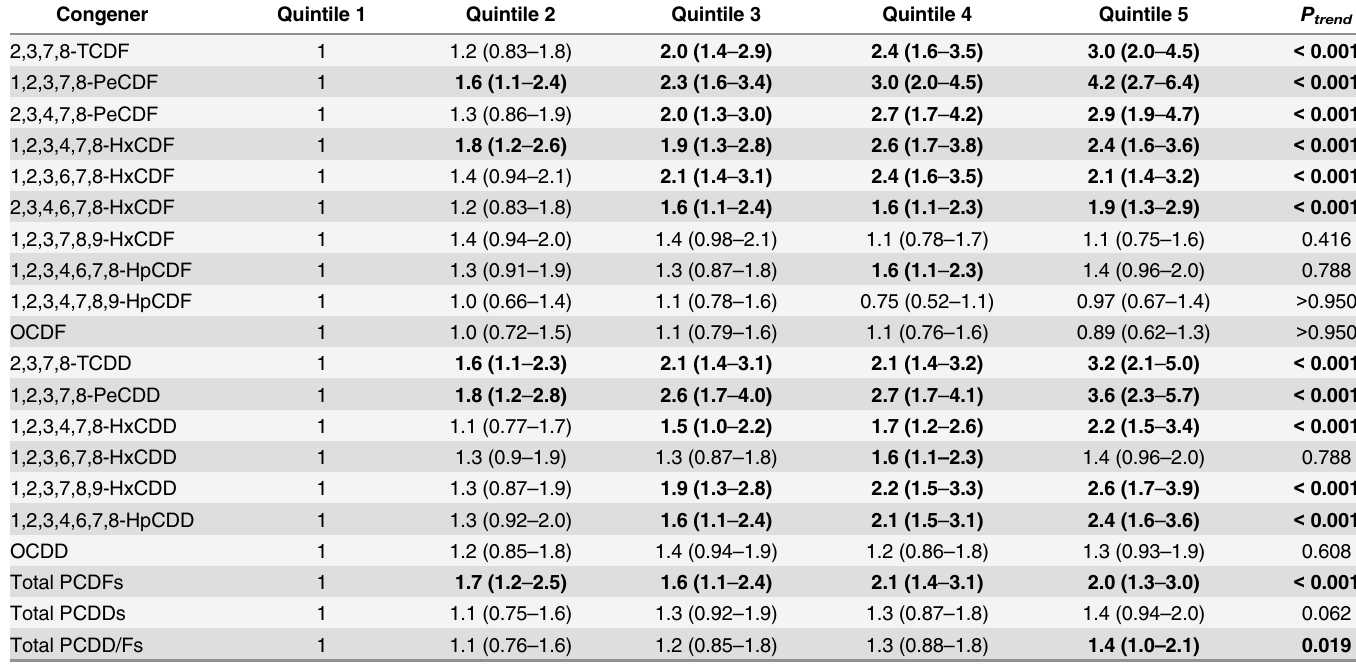
Table 3. Adjusted ORs (95% CIs) of the prevalence of abdominal obesity by quintiles of the concentrations of the selected congeners